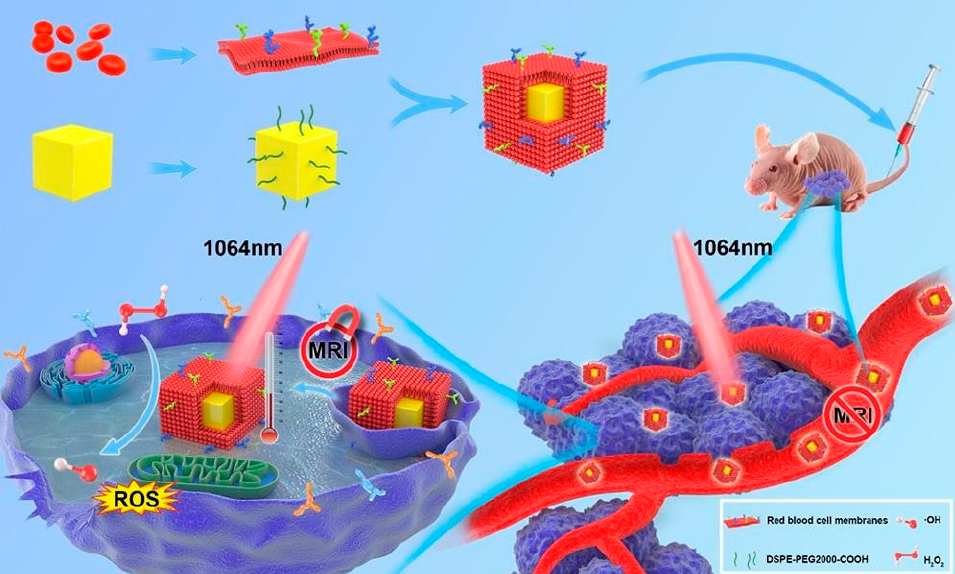
Figure 4. Schematic illustrating the fabrication and anti-tumor effect of FeS 2 @RBCs in vivo. With RBCs coating, FeS 2 @RBCs exhibited prolonged blood circulation, leading to improved tumor accumulation. FeS 2 @RBCs showed TME-enhanced MRI after reacting with H 2 O 2 in tumor regions for imaging-guided PTT. With an FDA-approved 1064 nm laser, FeS 2 @RBCs achieved effective PTT, which significantly augmented the CDT effects for tumor synergetic therapy. The growth of tumors could be significantly inhibited by a clinically approved NIR-II laser. Reprinted with permission from Ref. [68]. Copyright 2020, Elsevier Inc.